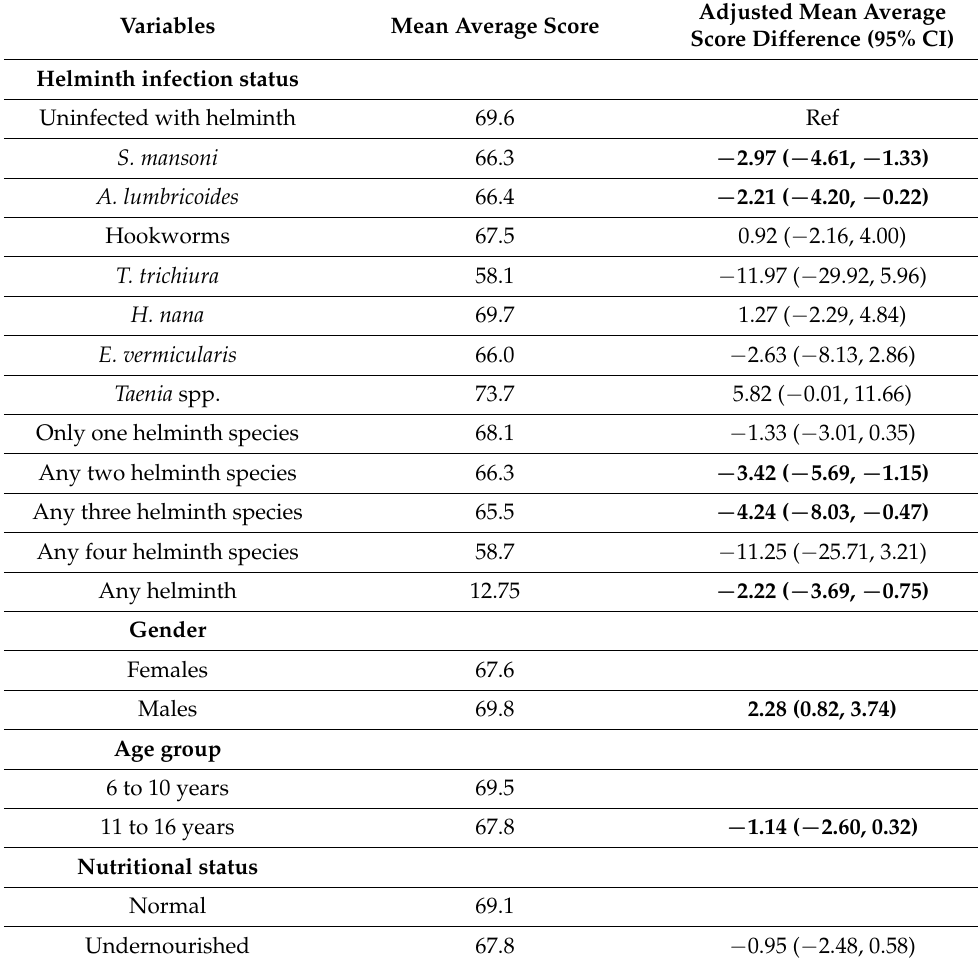
Table 6. Helminth infection status and academic score among school children in Maksegnit from May to July 2021 (N =